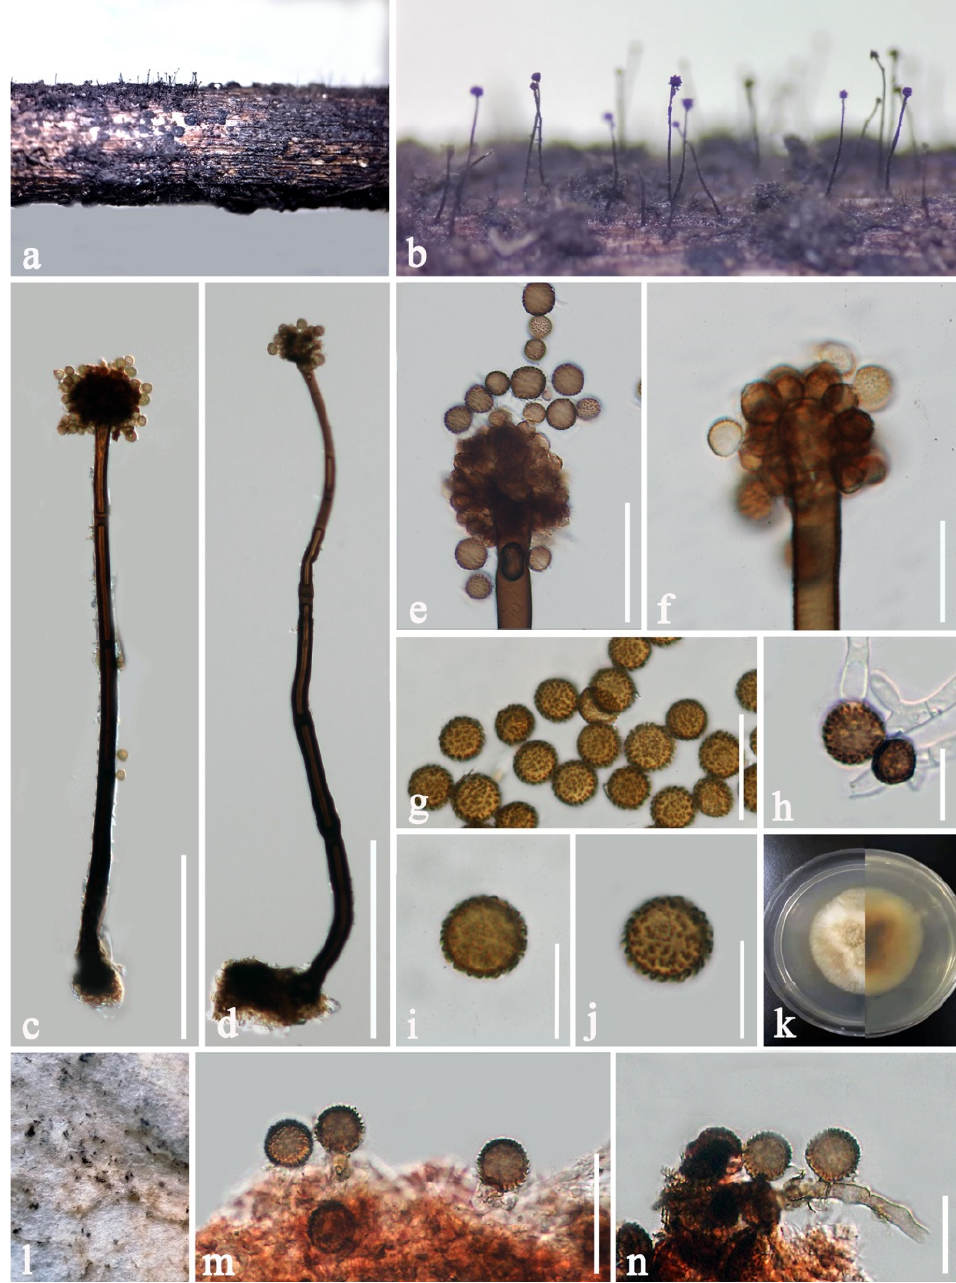
Figure 7. Periconia pseudobyssoides (KUN-HKAS 107382). ( a ) Standing hairy-like conidiophores of P. pseudobyssoides on host substrate; ( b ) close-up of conidiophores on substrate ( c , d ) conidiophores bearing spherical, conidial heads; ( e , f ) spherical conidial heads bearing conidiogenous cells and conidia; ( g , i , j ) conidia; ( h ) germinated conidia; ( k ) colony on PDA from above and below; ( l ) close-up conidial masses on PDA; ( m , n ) conidia sporulated in vitro. Scale bars: ( c , d ) = 200 µm, ( e ) = 50 µm, ( g , m ) = 30 µm, ( f , n ) = 20 µm, ( h – j ) = 15 µm.